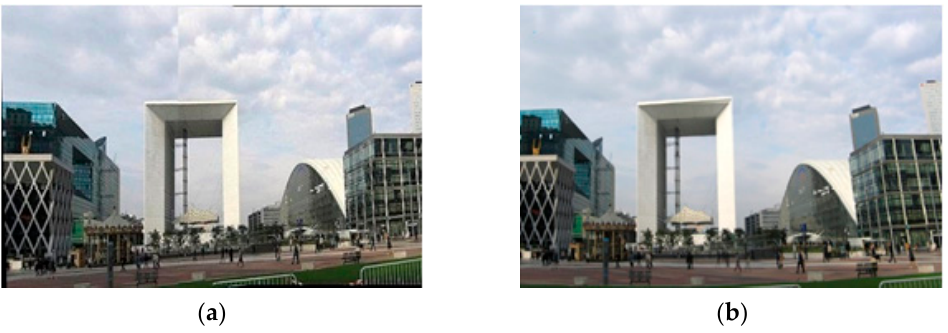
Figure 10. The fusion images for T2: ( a ) I-RANSAC; ( b ) IIR for T2( a ), I-RANSAC registration was used, and the fused images showed stitching traces; for T2( b ), IIR registration was used, and the fused images showed no stitching traces.